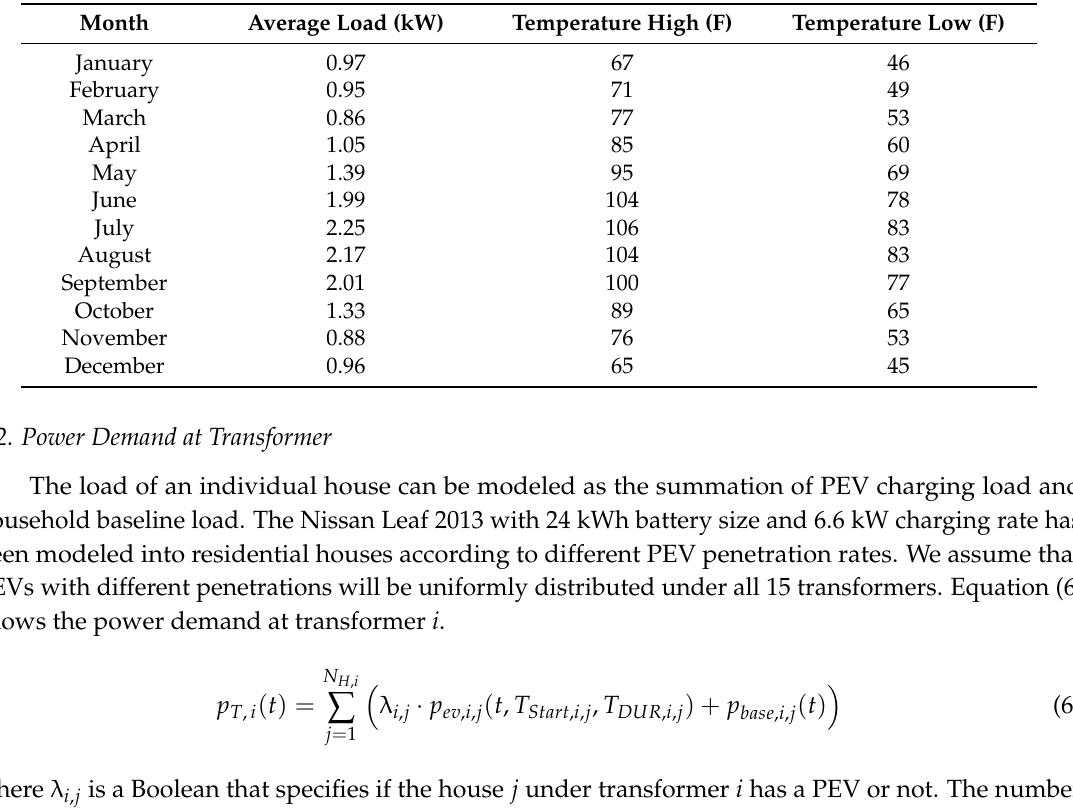
Table 1. Monthly average residential load and ambient temperature in Arizona,